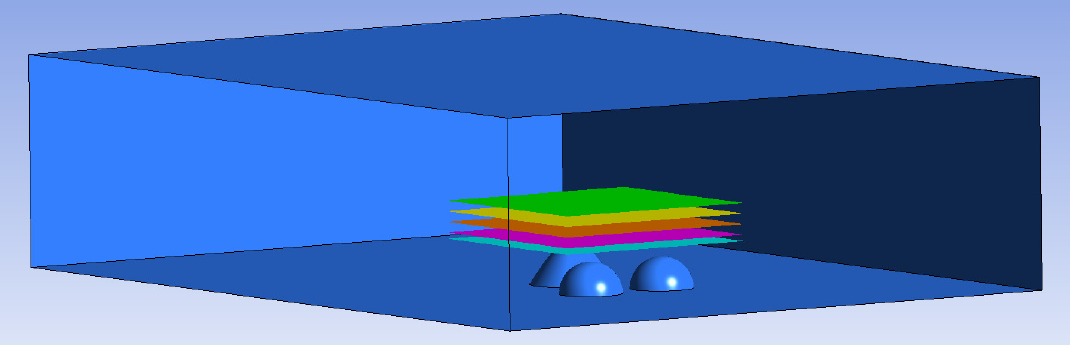
Figure 11. Diagram of velocity fields in five planes (five different colors) to be reconstructed.